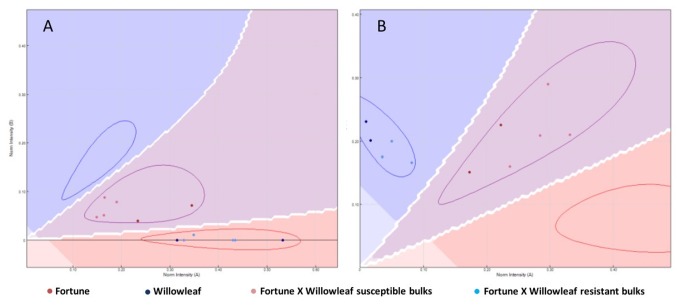
Plot showing Bulked Segregant Analysis results for the CiC3248-06 (A) and CiC6243-03 (B) markers, distinguishing between susceptible and resistant genotypes and bulks.